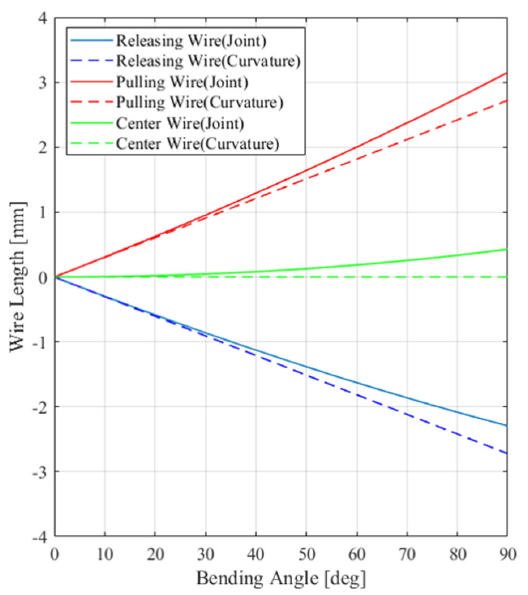
Figure 8. Comparison of driving wire length between curvature model and joint model.